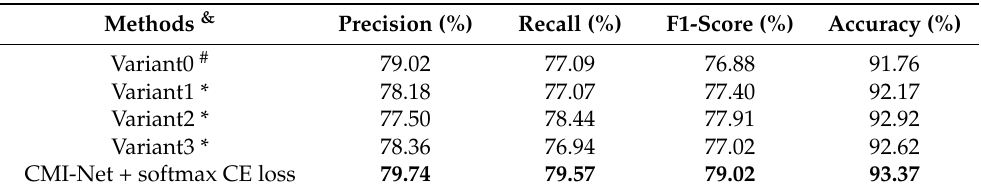
Table 2. Performance comparison of our CMI-Net with its variants. The best results for each metric are highlighted in